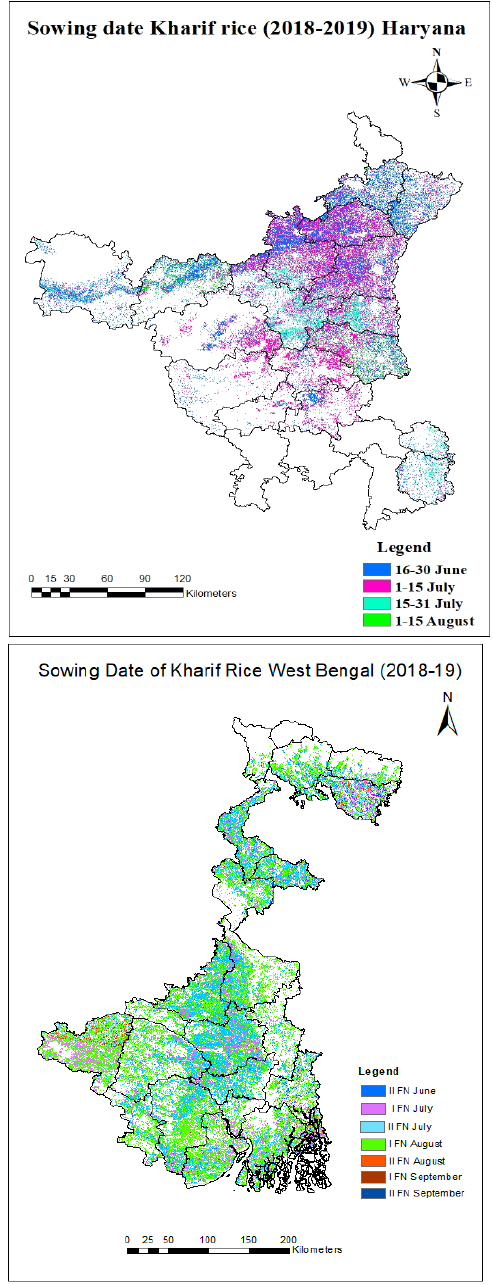
Figure 13: Rice transplantation progress in the states of Haryana (above) and West Bengal (below).